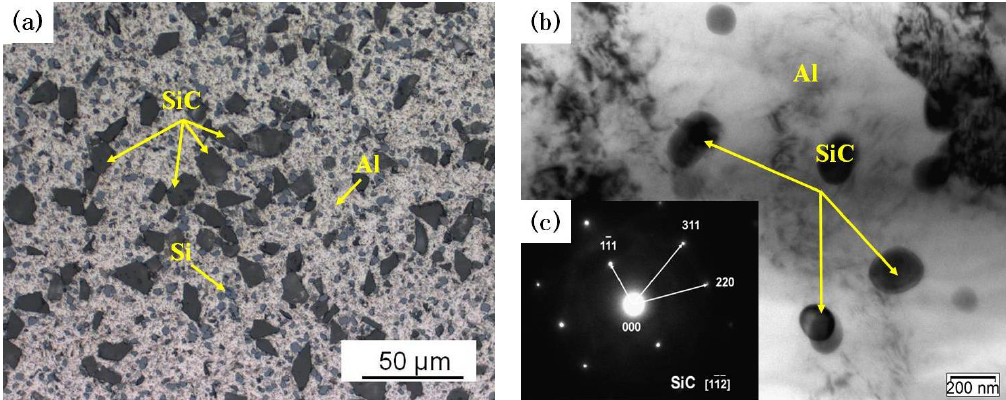
Figure 1. ( a ) Optical microstructure and ( b ) transmission electron microscopy (TEM) images of the composites; ( c ) diffraction pattern of the nano SiC.